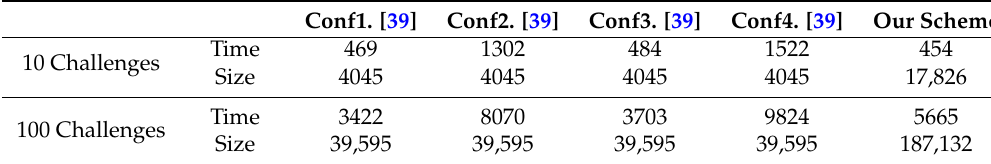
Table 2. Comparative data: time (ms) and size